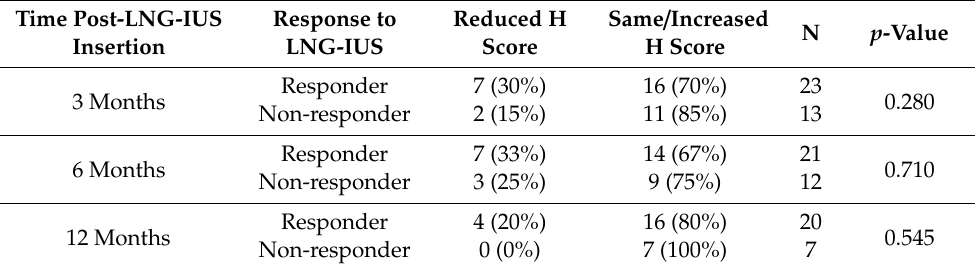
Table 5. Proportion of responders vs. non-responders to the LNG-IUS showing reduced vs. same / increased H score compared to baseline after LNG-IUS